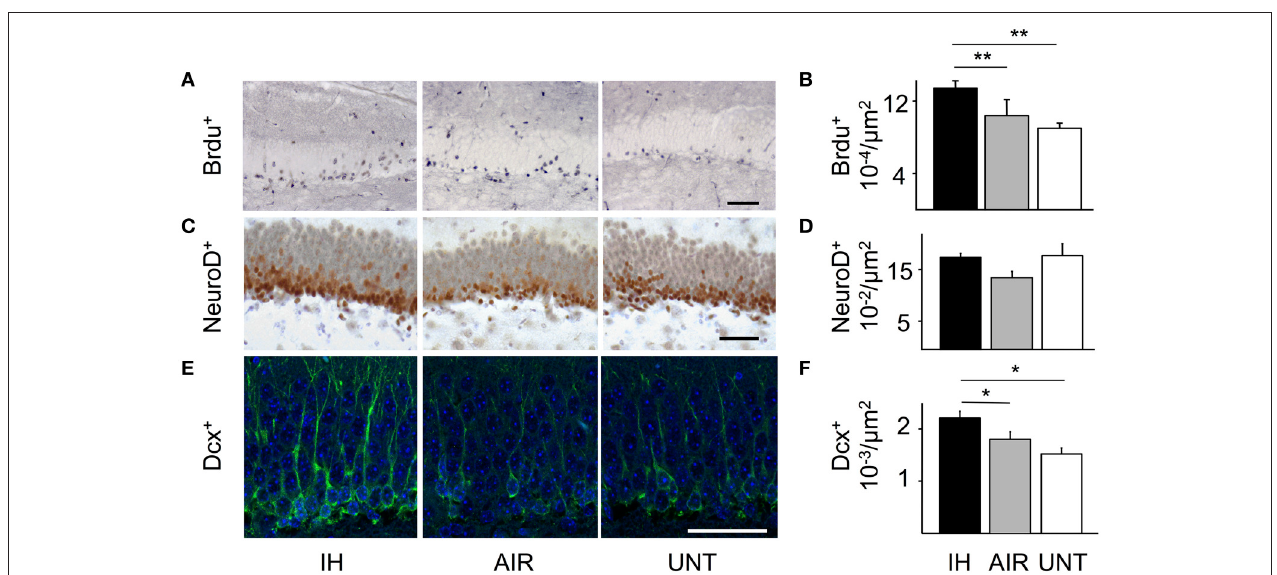
FIGURE 4 | IH-induced increase in neurogenesis. Neurogenesis was analyzed in the dentate gyrus of mice postnatally exposed to intermittent hypoxia (IH, n = 22 ), exposed to air (AIR, n = 21 ), or left untreated with their dams (UNT, n = 22 ). (A) Cell proliferation was detected by BrdU labeling on P13. (B) Densities of BrdU-positive cells. IH increased the density of BrdU-positive cells on P13 compared to AIR. (C) NeuroD immunolabeling on P21. (D) IH tended to increase the density of NeuroD-positive cells, although the difference was not significant (IH vs. AIR: p = 0.055 ). (E) DCX immunolabeling on P30. (F) Densities of DCX-positive cells on P30. IH increased DCX-positive cell densities (IH vs. AIR group: p = 0.049 ). Scale bars = 50 µ m. Values are group means ± SEM. * p < 0.05 , ** p < 0.01 .